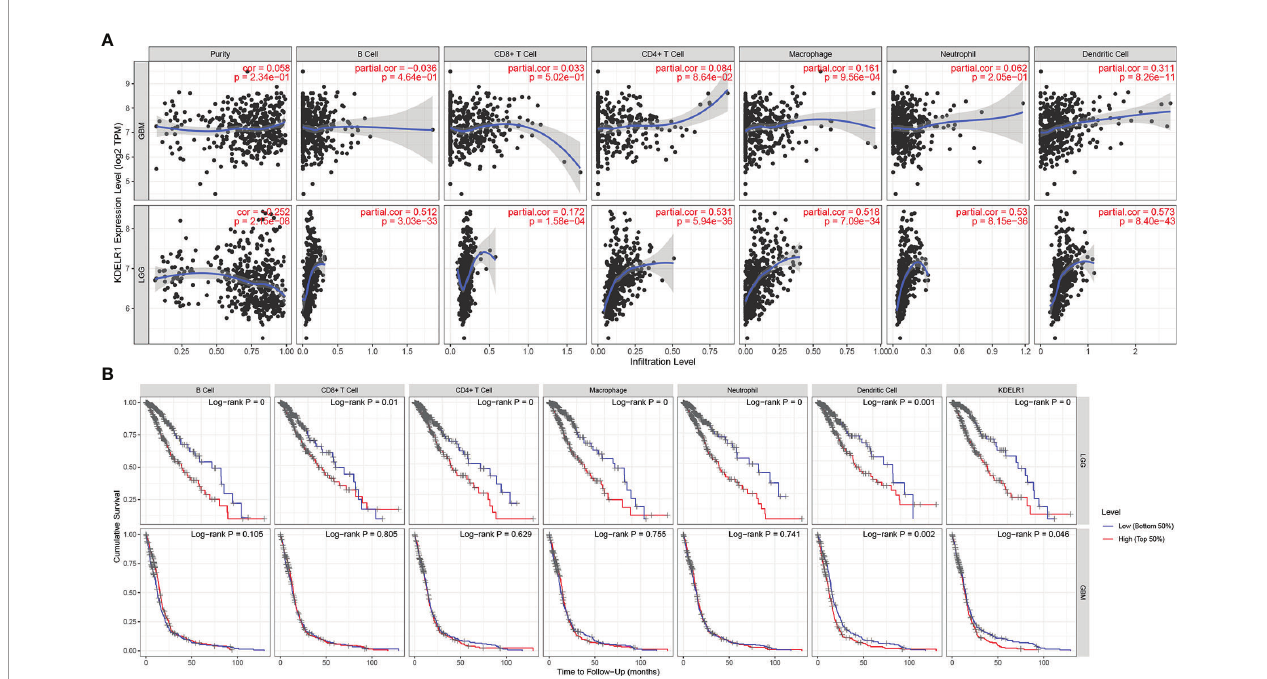
FIGURE 8 | The relationship between the KDELR1 expression level, tumor purity, and immune cell in fi ltration was explored via the TIMER database. (A) KDELR1 was signi fi cantly correlated with immune cell in fi ltration in GBM and LGG patients. (B) Kaplan – Meier survival analysis of several immune cells in GBM and LGG